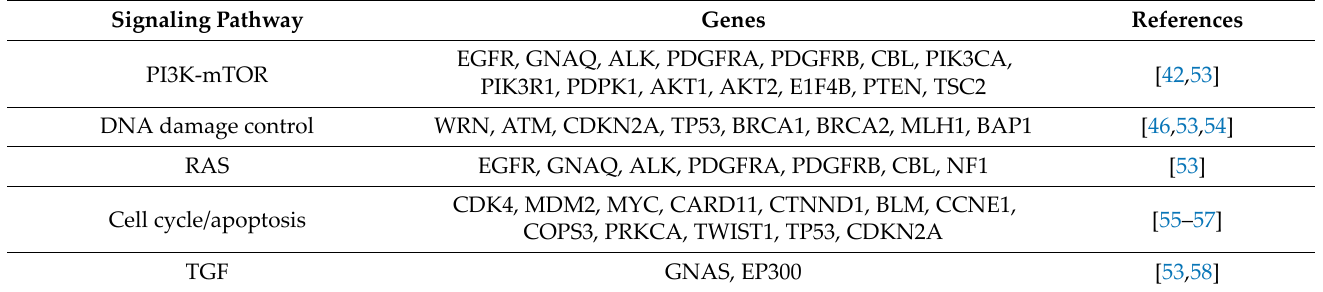
Table 2. Somatic mutations in cancer genes in osteosarcoma‑associated signaling pathways. Signaling Pathway